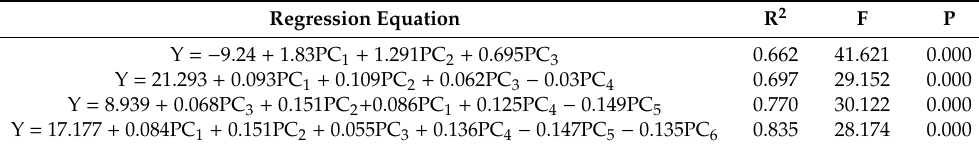
Table 6. Regressive equations of PC of representative species predicting AGB of community.